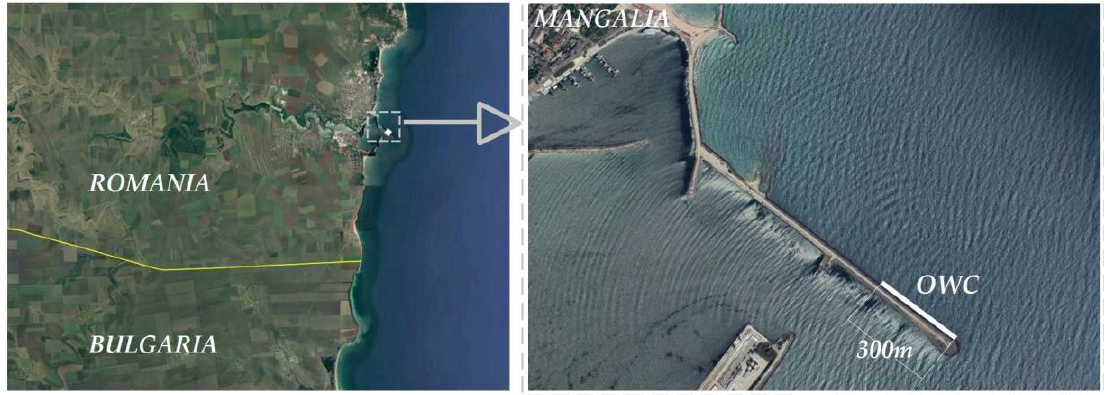
Figure 11. Port of Mangalia and considered array of OWCs (source: Google Maps).